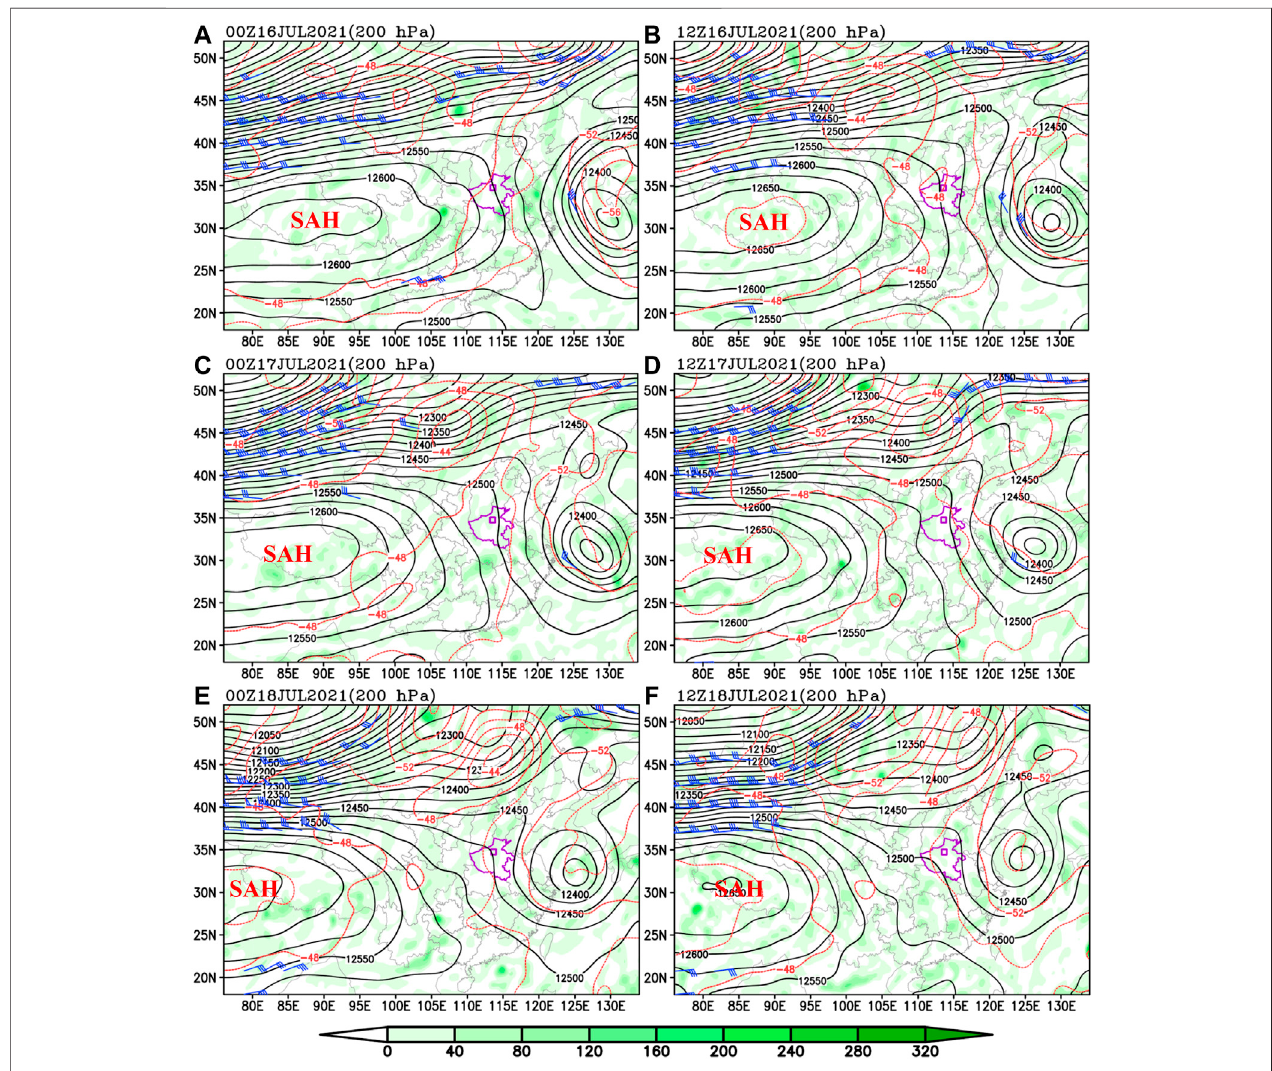
FIGURE 2 | Divergence (shading, units: 10 − 6 s − 1 ), geopotential height (black solid lines, units: gpm), temperature (red lines, units: ° C), and strong winds (above 30 m s − 1 ; a full bar represents 10 m s − 1 ) at 200 hPa, where the small purple box marks the location of Zhengzhou. SAH, South Asia high.